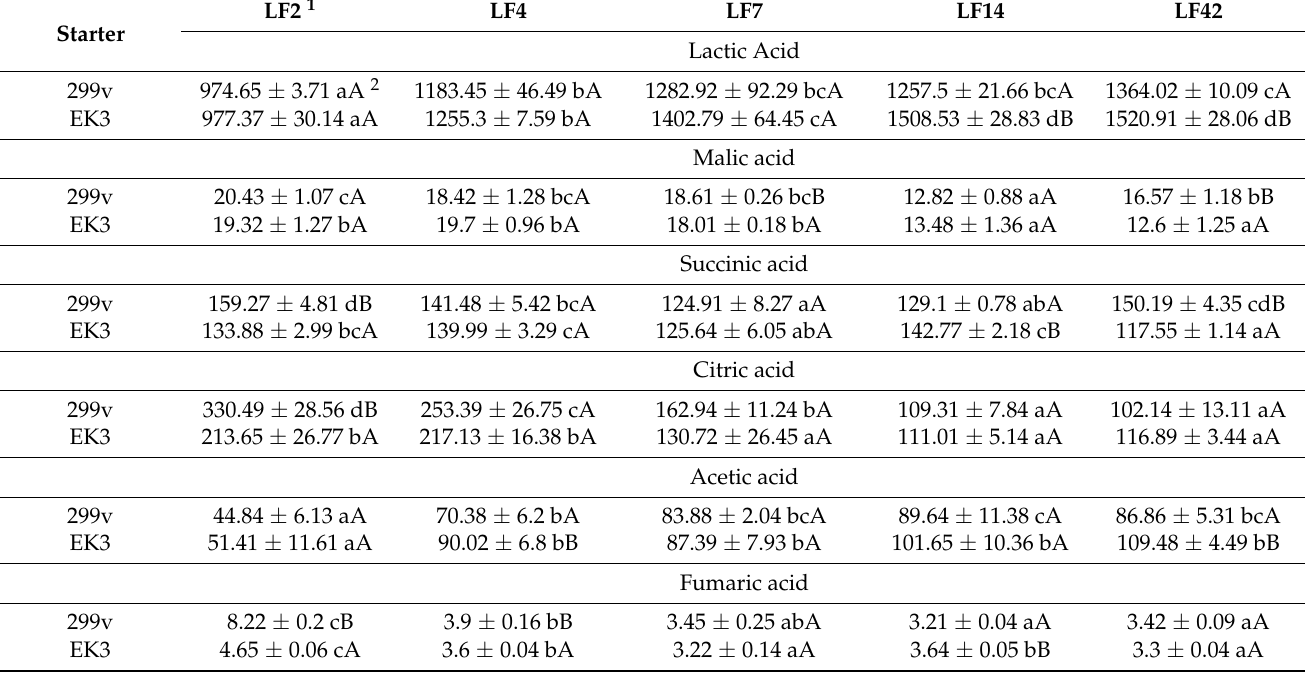
Table 6. Organic acid content in brine (mg/100